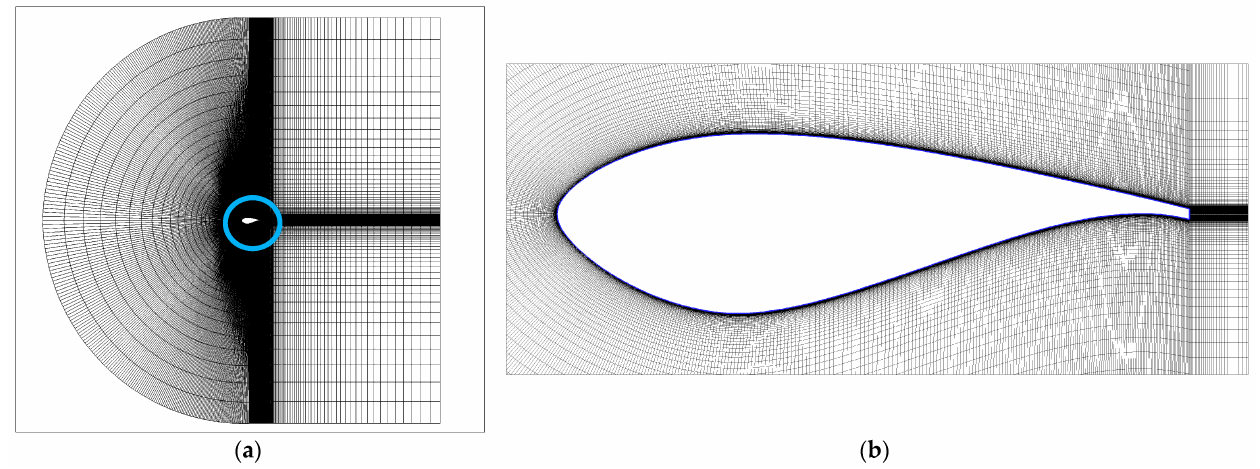
Figure 11. DU300 airfoil grid: ( a ) sliding interface marked by blue; ( b ) boundary layer